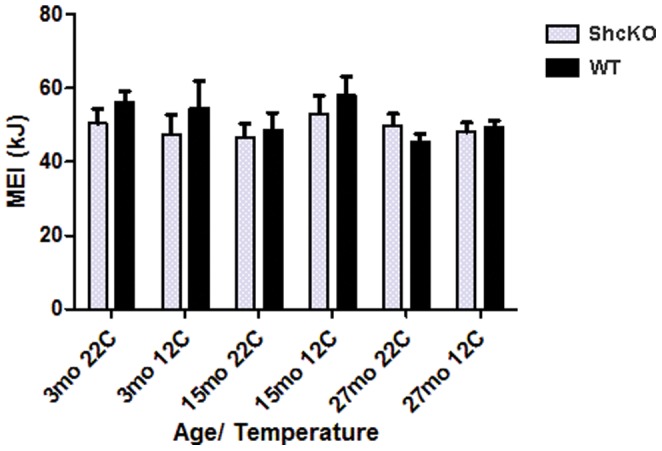
Metabolizable energy intake (MEI) in ShcKO and wild-type (WT) mice housed at 22°C or 12°C.Mean (±SEM) 24 hour energy intake measured in 3, 15 and 27 month old animals. Energy intake measurements at 22°C were completed over a 1 week period while 12°C measurements were completed during 24 hour acute cold exposure. ShcKO = p66 Shc(−/−) mice, mo = months.